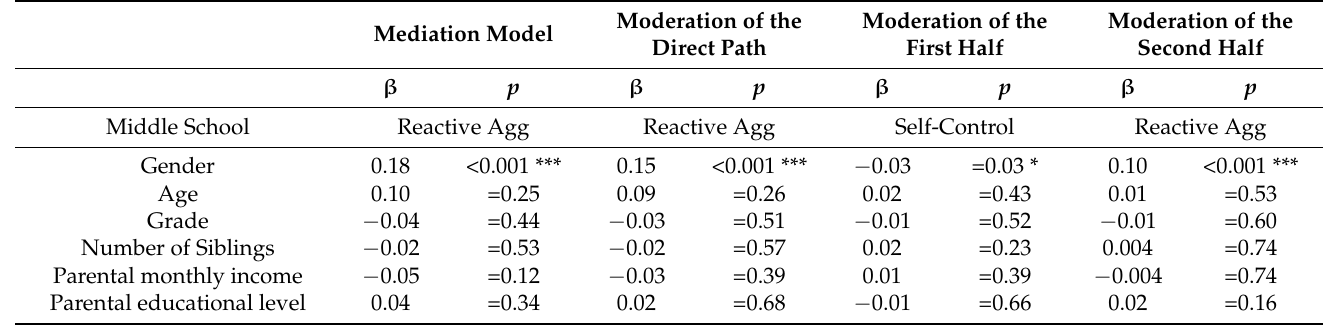
Table 5. Indices of Mediation and Moderation models of the College